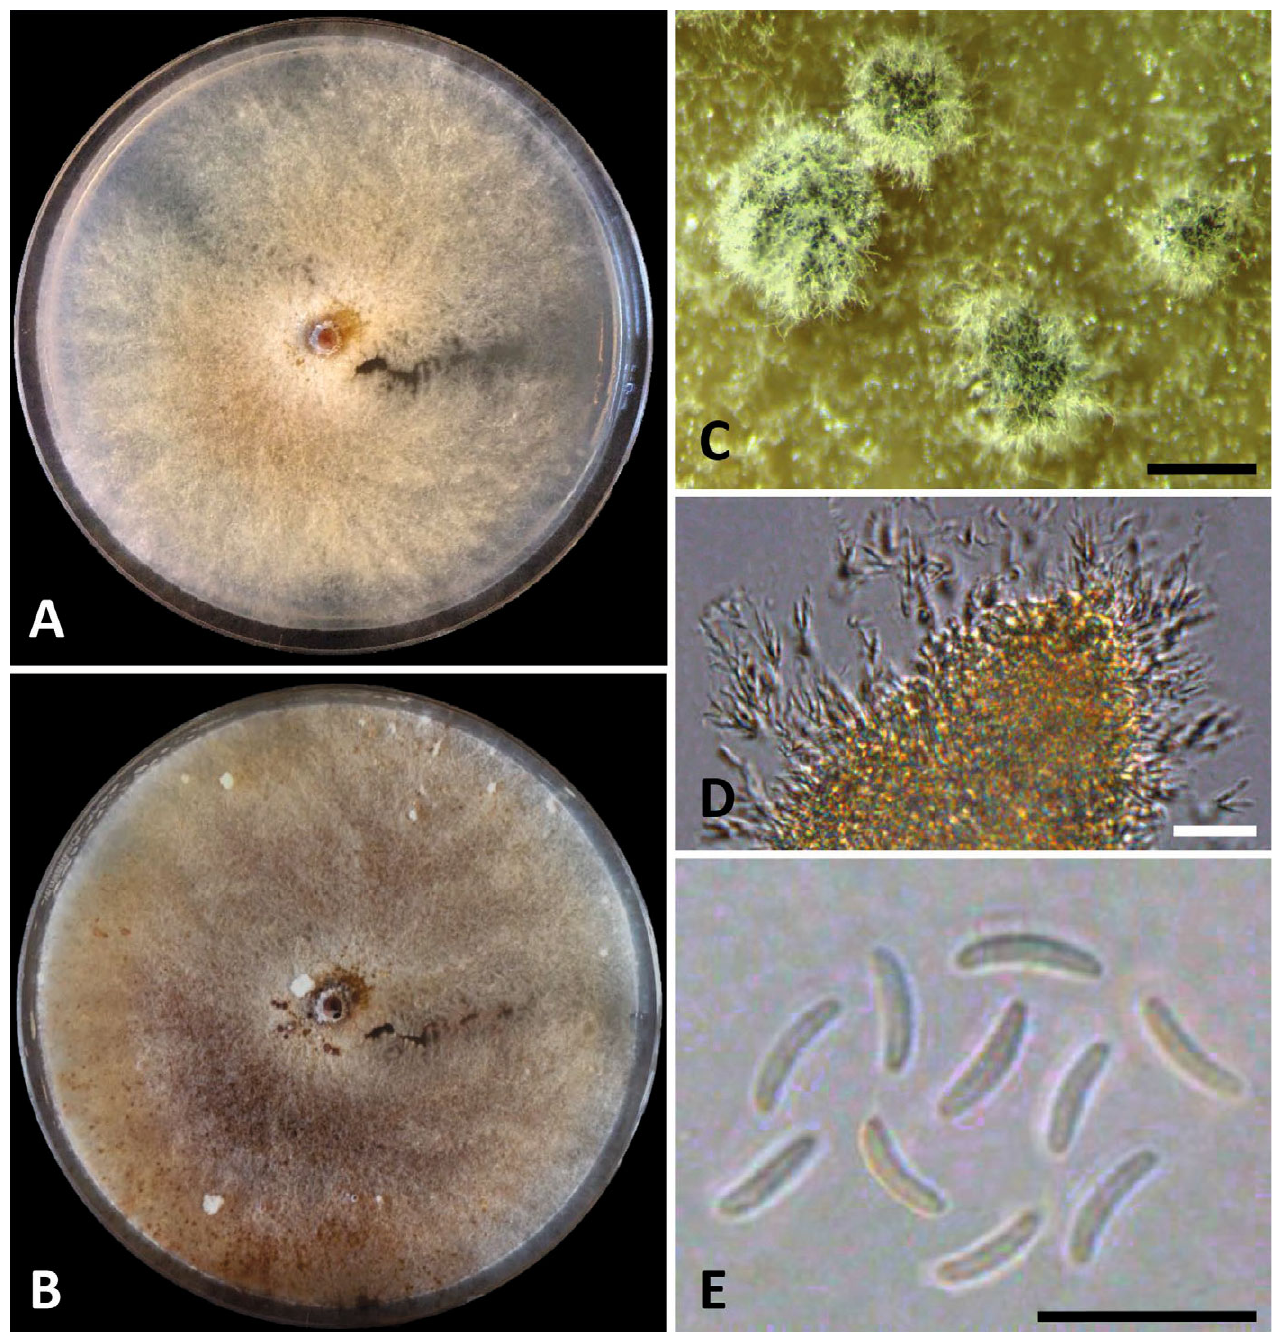
Fig. 13. Cytospora parakantschavelii (CBS 144243). A. Seven-day-old PDA culture. B. Fourteen-day-old PDA culture. C. Conidia.